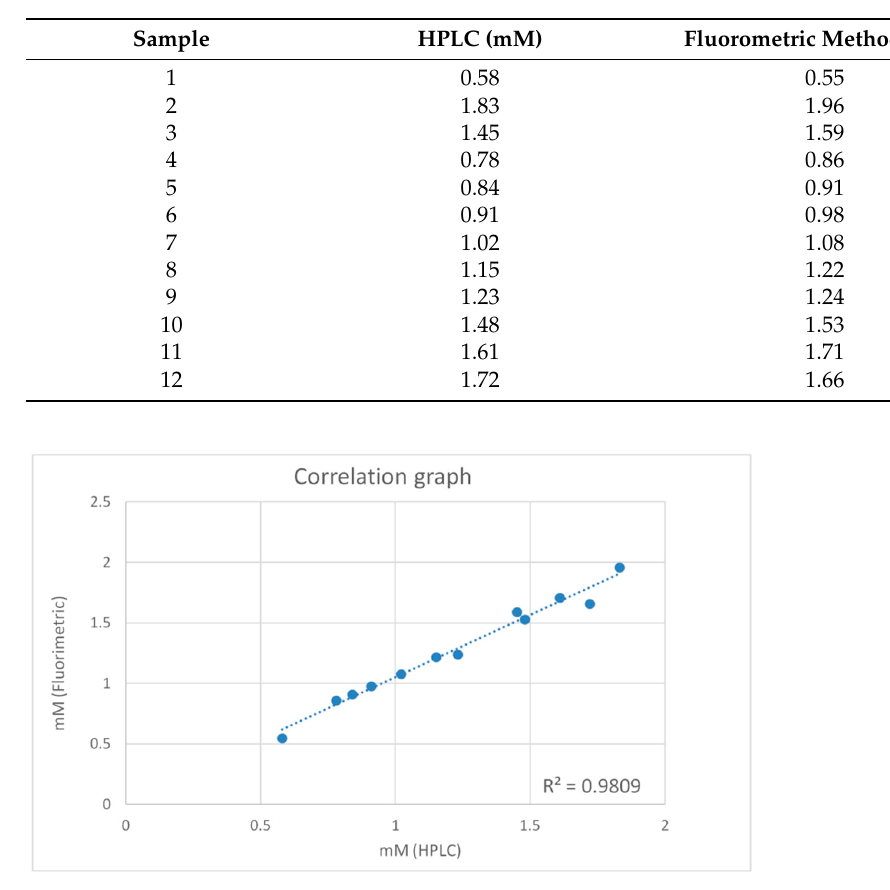
Figure 5. Correlation between optimized direct fluorometric method and validated HPLC analyses.